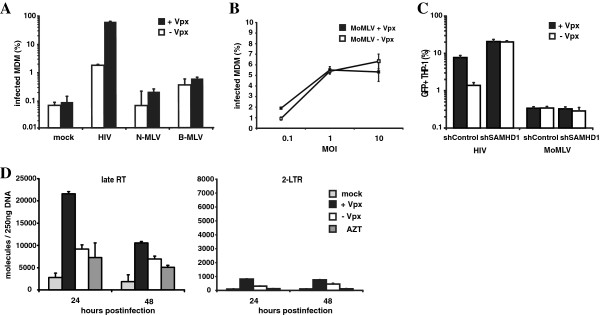
Vpx relieves SAMHD1-mediated restriction of MLV RT but does not allow for productive infection of non-dividing cells. (A) MDM were preincubated with Vpx-containing (+Vpx) or control VLP (−Vpx). The cells were then incubated with control supernatant (mock) or infected with VSV-G pseudotyped HIV-GFP, N-tropic MLV-GFP (N-MLV), or B-tropic MLV (B-MLV) at a MOI = 1 or (B) with increasing amounts of NB-tropic MLV-GFP (NB-MLV). (C) THP-1 cells that express shSAMHD1 (shSAMHD1) or control shRNA (shControl) were differentiated with PMA, preincubated with VLP and then infected with HIV-GFP or MLV-GFP at MOI = 1. (D) MDM were incubated with Vpx-containing (+Vpx) or control VLP (−Vpx). After 2 h, the cells were infected with control supernatant (mock) or with NB-tropic MLV reporter virus. Cellular DNA was isolated 24 and 48 h postinfection and used as a template in qPCR to amplify late reverse transcriptase products and 2-LTR circles. AZT was added to one well treated with Vpx-containing VLP prior to infection to control for contaminating plasmid. The data are presented as the average of triplicates with error bars indicating the standard deviation. Reporter gene expression in the infected cells was analyzed three days postinfection by flow cytometry. Similar results were obtained in three independent experiments with different donors.